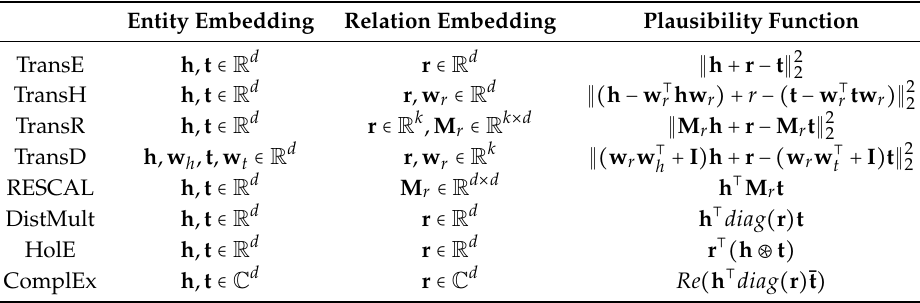
Table 1. Entity and relation embeddings of knowledge graph